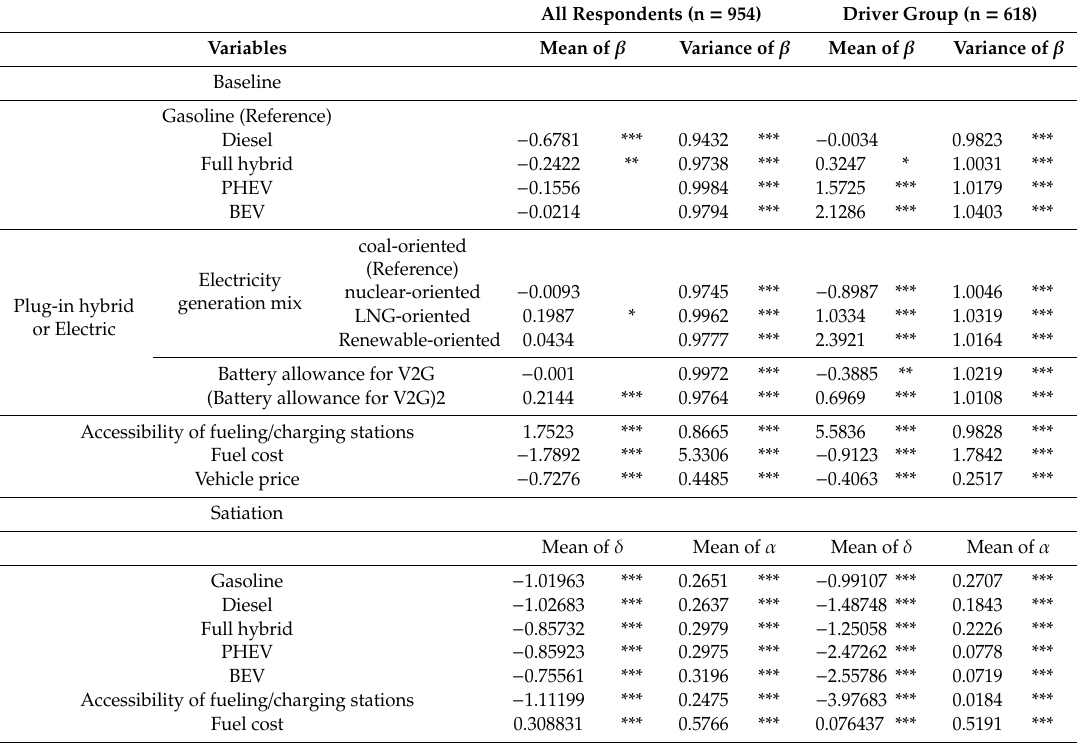
Table 4. The mean and variance of draws for the baseline utility and satiation